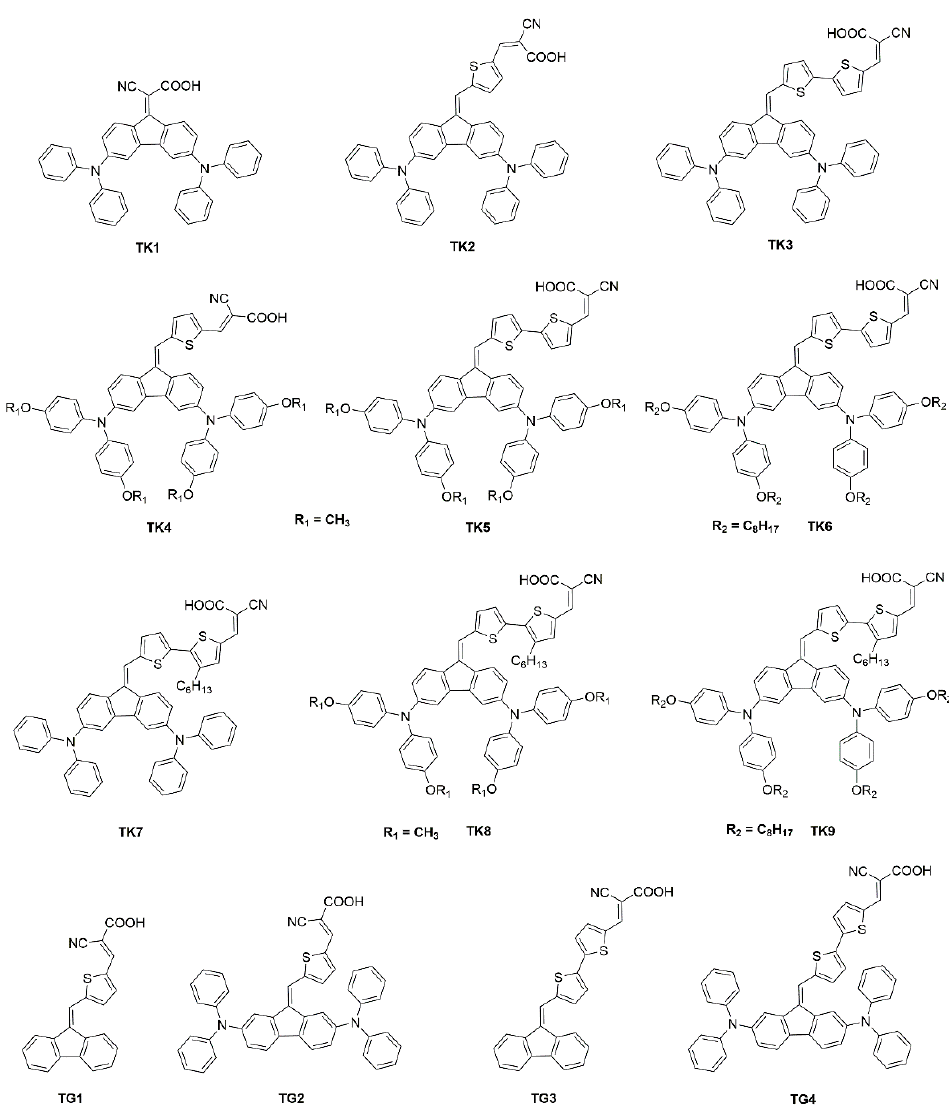
Figure 6. Dibenzofulvene (DBF)-based organic dyes. Synthesis of Dibenzofulvene (DBF)-Based Organic Dyes Organic dyes TK1 , TK2 and TK3 were synthesized as reported in Scheme 6 [75].